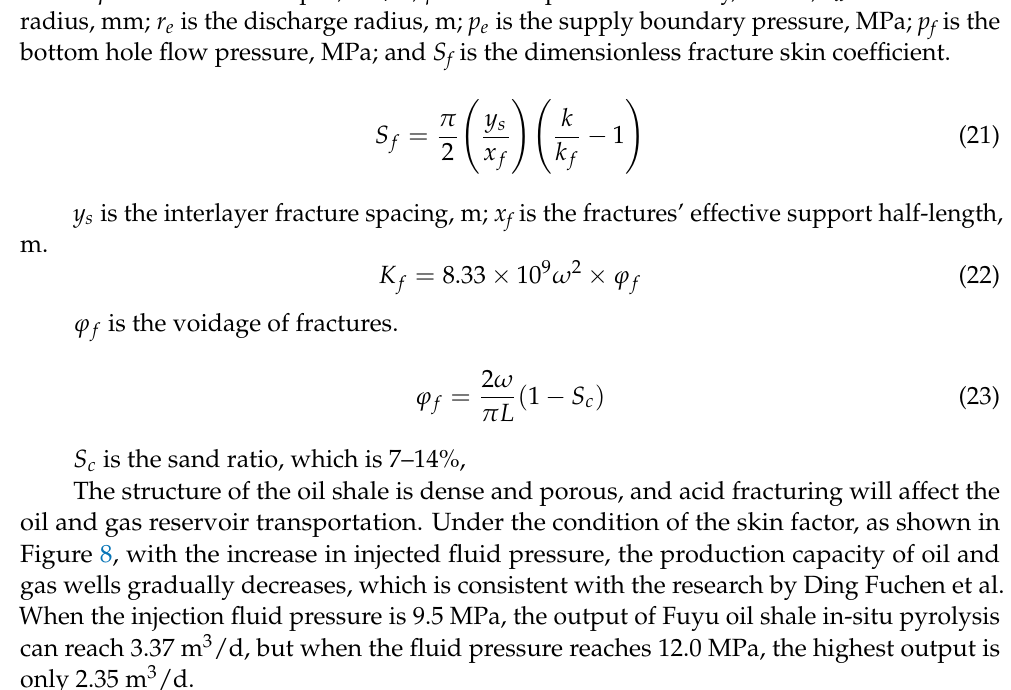
Figure 7. Schematic diagram of the influence of displacement flow on oil and gas recovery.